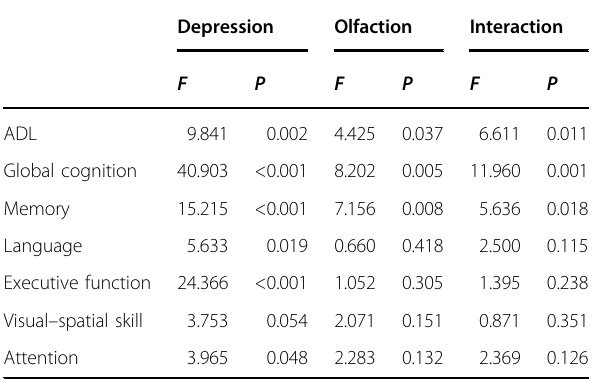
Table 2 Additive effects of LLD and OI dysfunction on cognitive impairment and ADL